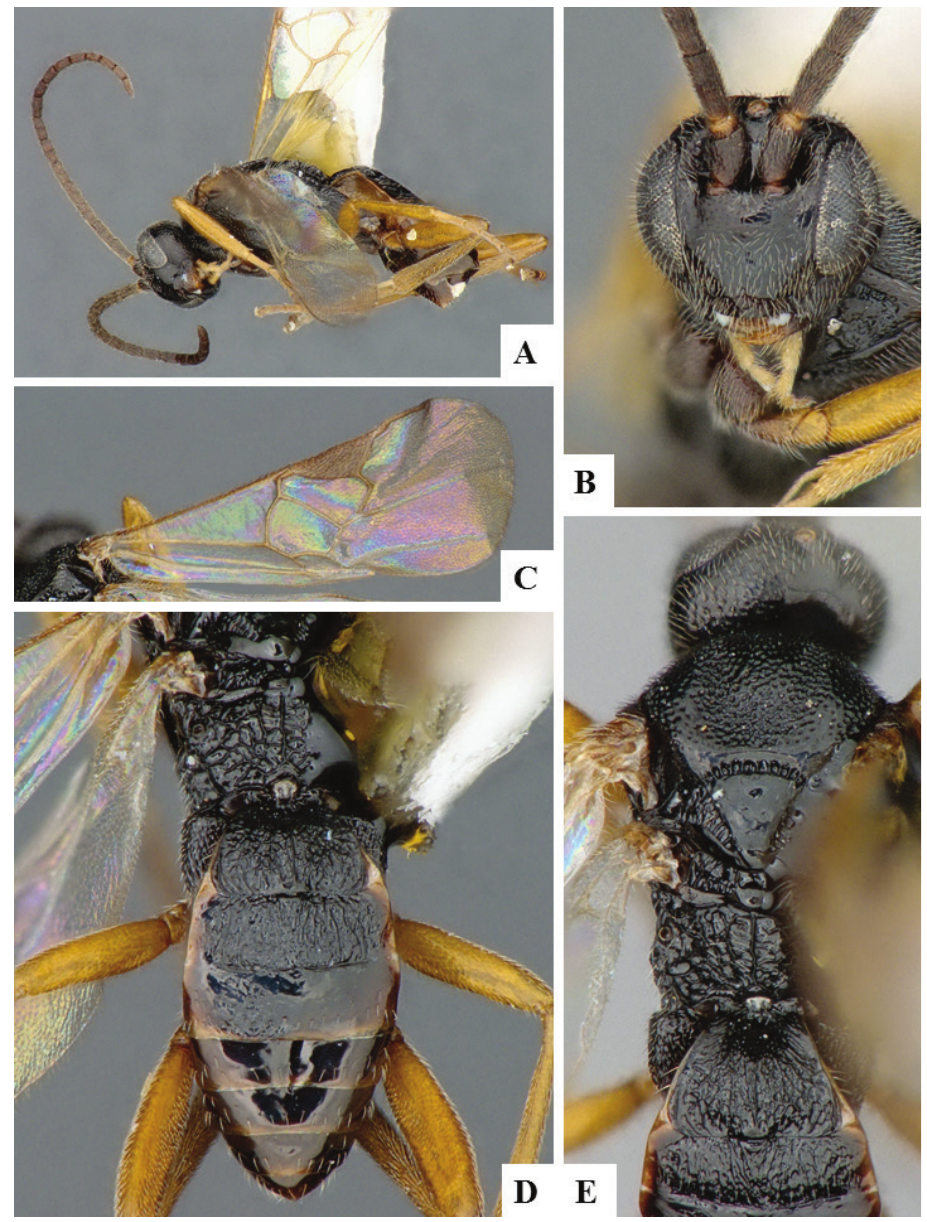
Figure 14. Cotesia acronyctae. A Habitus, lateral B Head, frontal C Wings D Metasoma, dorsal E Head and mesosoma,